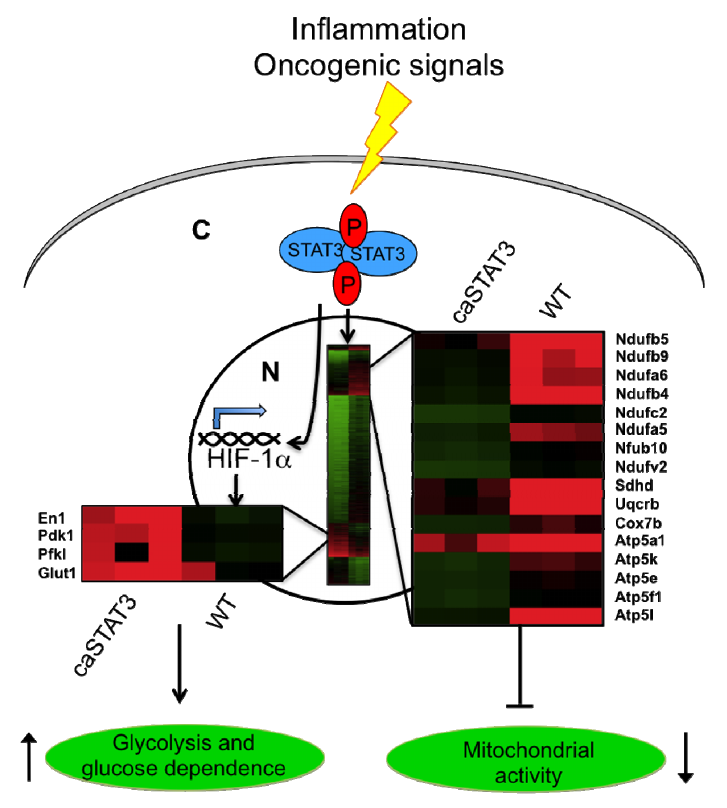
Figure 4. Constitutively active STAT3 regulates mRNA expression of metabolic